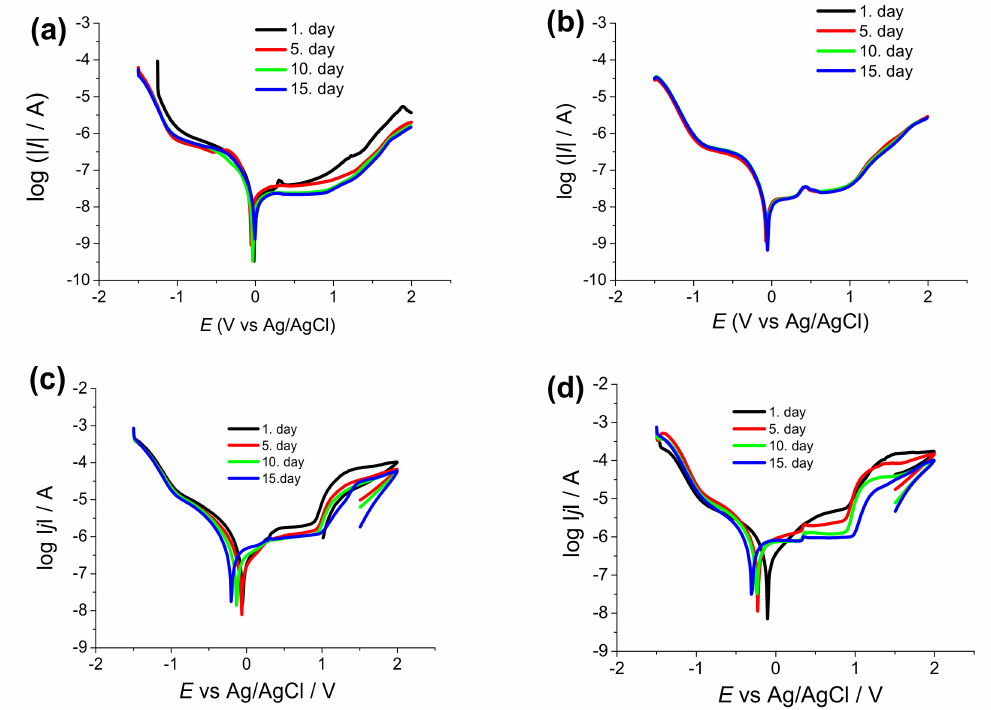
Figure 6. Potentiodynamic polarization curves of the uncoated Ti6Al4V alloy ( a ) and CPC coating (S5) ( b ) in Ringer’s solution as well as Ti6Al4V alloy ( c ) and CPC coating ( d ) in SBF solution